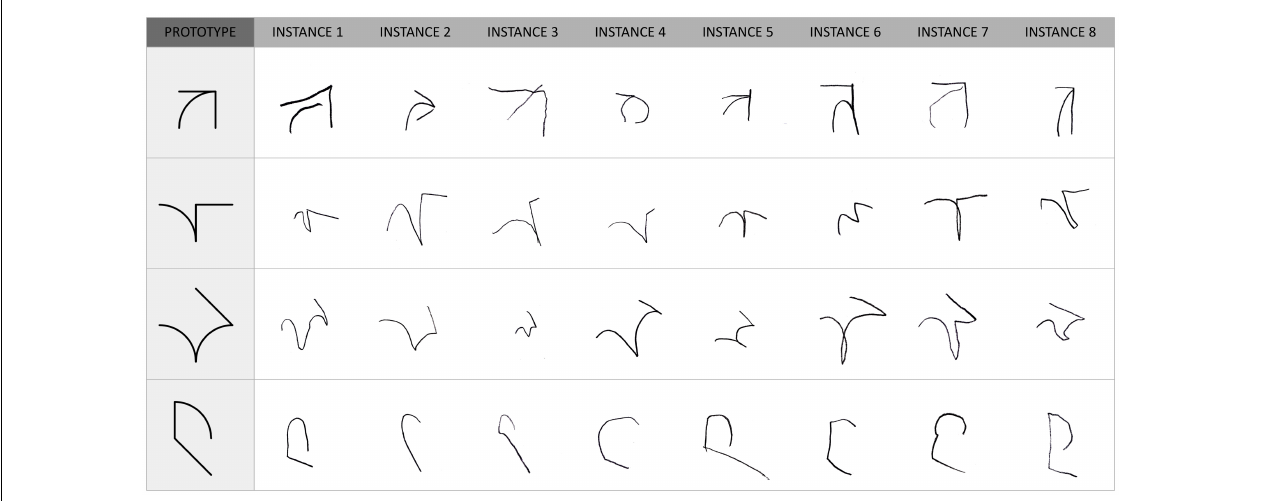
FIGURE 4 | The 32 handwritten productions used as experimental stimuli in the categorization task.